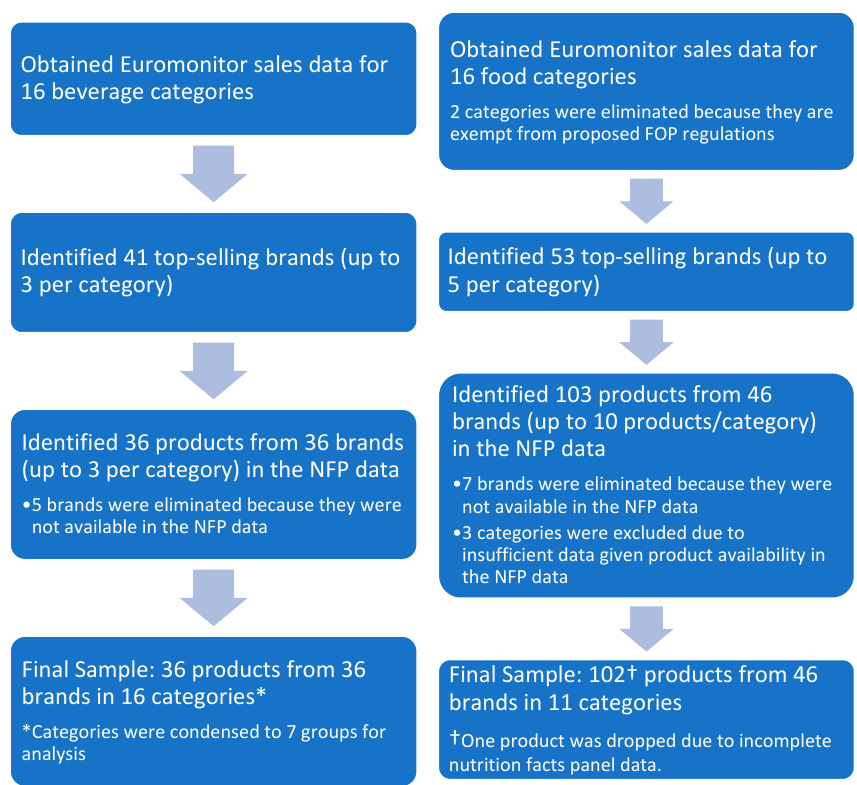
Figure A1. Sample Selection Process.The NFP (Nutrition Facts Panel) refers to the data collected from photographing products available in supermarkets in Bogota and entered into the REDCap (Research Electronic Data Capture) database. Table A4. Median quantity per 100 g / mL of nutrients of concern by food group in 2016 and 2018 (based nutrients regulated under the Chilean model) 1,2.